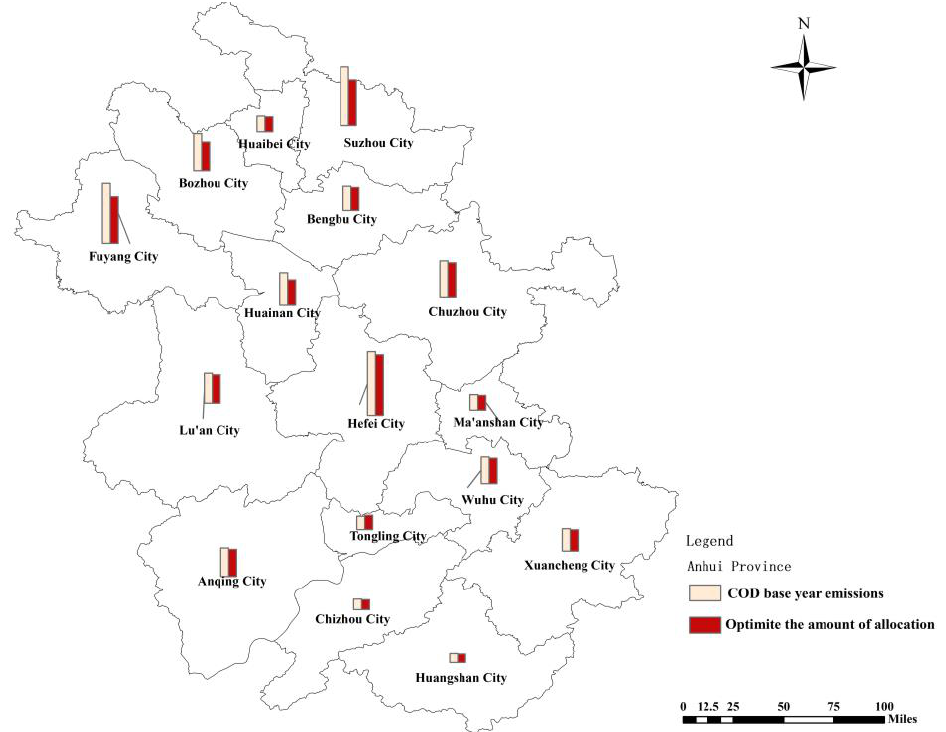
Figure 10. Distribution chart of comparison between COD optimized distribution results and base year.